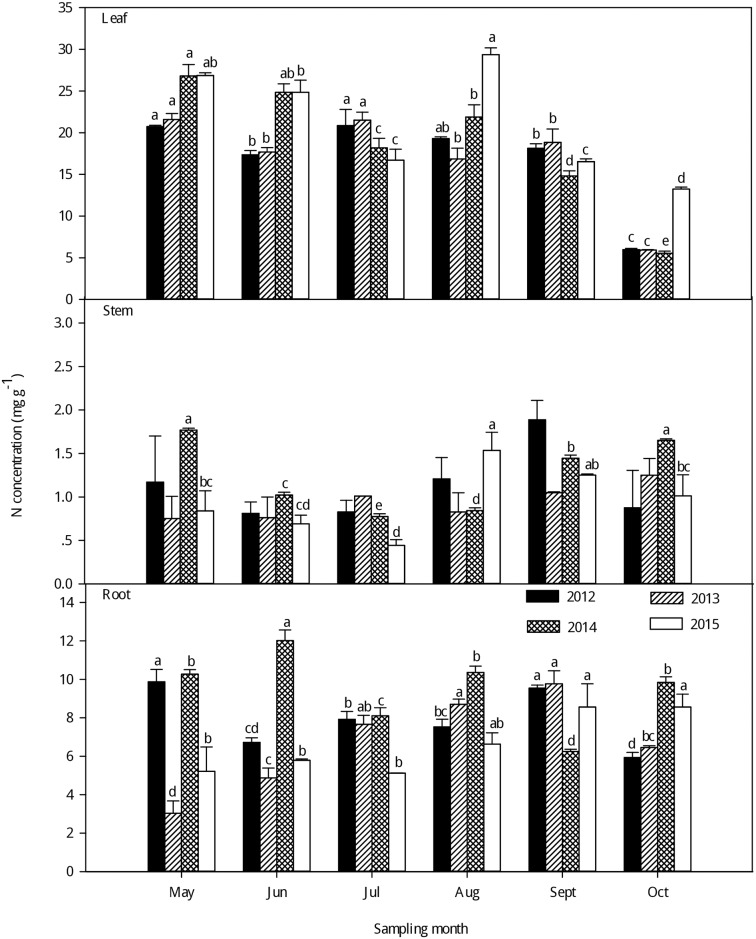
Seasonal variations in the N concentrations (mean ± SE) in different organs of larch stands from 2012–2015.Different lowercase letters represent significant differences among different growing seasons at P < 0.05.